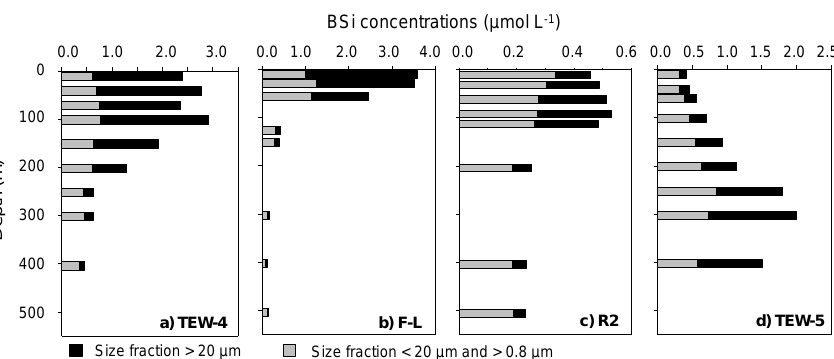
Figure 11. Vertical profiles of BSi concentrations for two size fractions (>20µm in black and between 0.8 and 20µm in grey) at TEW-4 (a) , F-L (b) , R2 (c) and TEW-5 (d) . These four stations were chosen to illustrate the four typical vertical profiles observed over the study area: TEW-4 represents typical profile of the stations A3-2 and E (from E-1 to E-5), F-L represents typical profile of stations E-4W and those located in the PFZ, R2 represents typical profile of the low productive stations (R2, TNS-1, TNS-2, TEW-2, TEW-3, TEW-5 and TEW-6) and TEW-5 is the only station showing such a vertical